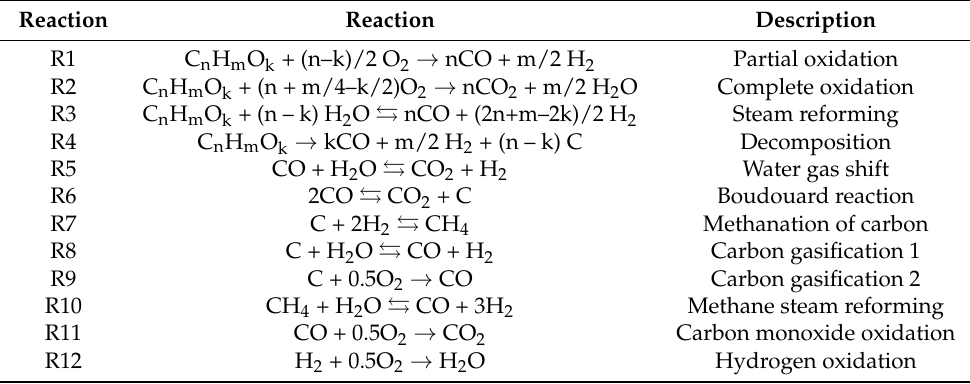
Table 1. List of all possible global reactions taking place in the reformer and shift